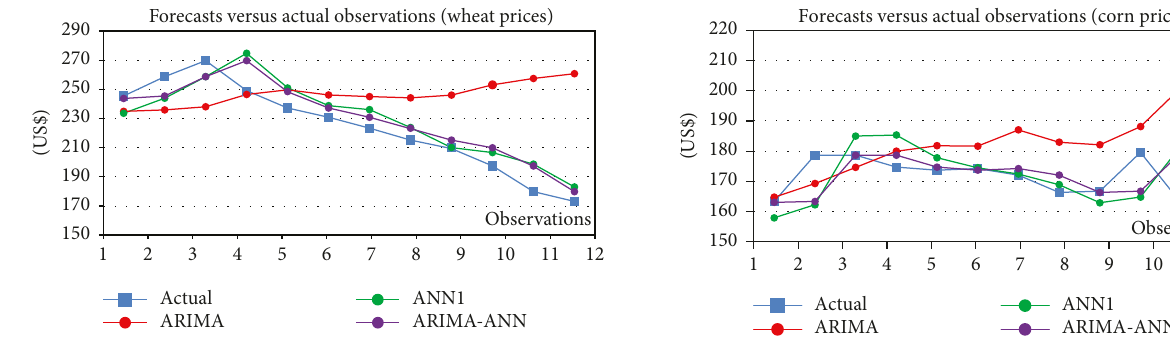
Figure 12: Forecasts of corn prices versus actual observations for , and the the 12 testing records (with the use of ARIMA, ANN 1 proposed ARIMA-ANN models).